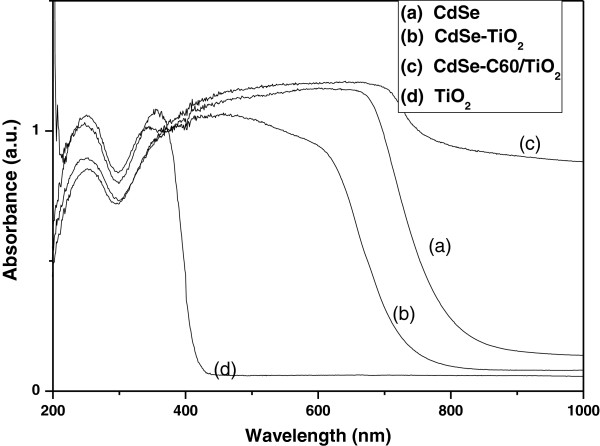
UV–vis diffuse reflectance spectra of CdSe, CdSe-TiO2, TiO2, and CdSe-C60/TiO2.